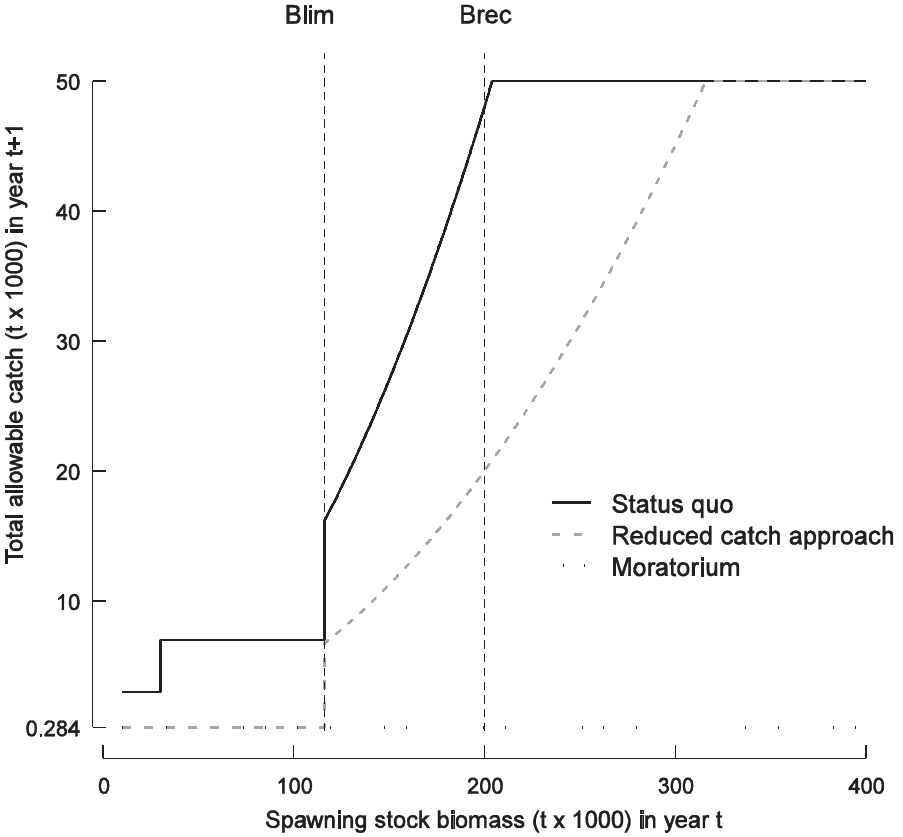
CIL . The adjusted Pearson’s coefficient r ~ 0 : 58 , with p { value v 0 : 01 . e